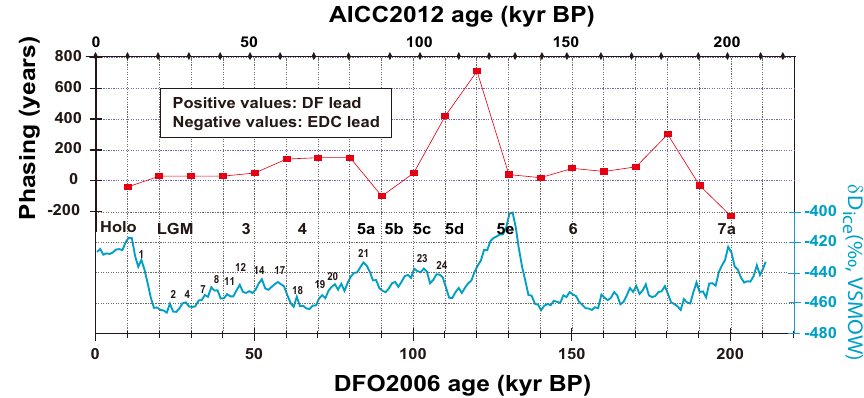
Figure 8. To investigate features of the phasing between the δ D ice records as a function of time, the correlation coefficient of the δ D ice records, shifted by x years, was calculated on 20000-year time windows. The calculation was repeated for every 10000 years. The maximums of correlation on each 20000-year time window are given with red marker symbols and lines. Positive and negative values mean lead of DF and EDC, respectively. Blue trace with indications of the marine isotope stages and Antarctic isotope maxima (AIM) is δ D ice of DF core averaged over every 1kyr for reference (Uemura et al.,